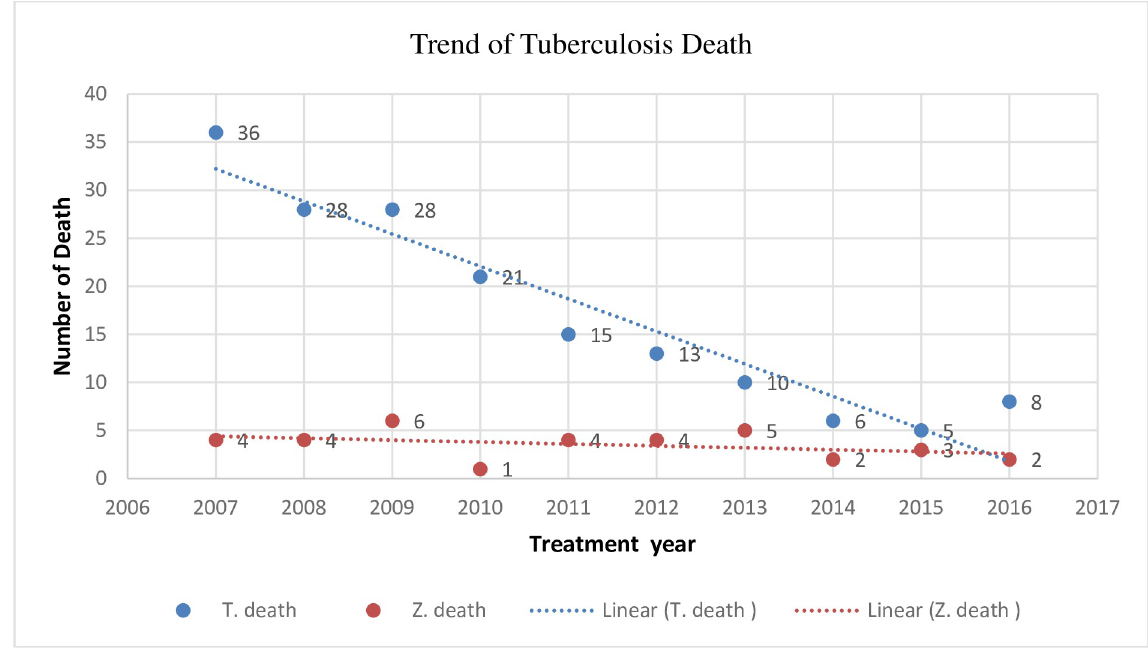
Fig 2. Trend of tuberculosis death in the past ten years (January 2007- December 2016) in women, Tigray N = 2084 and Zigong N = 4047.